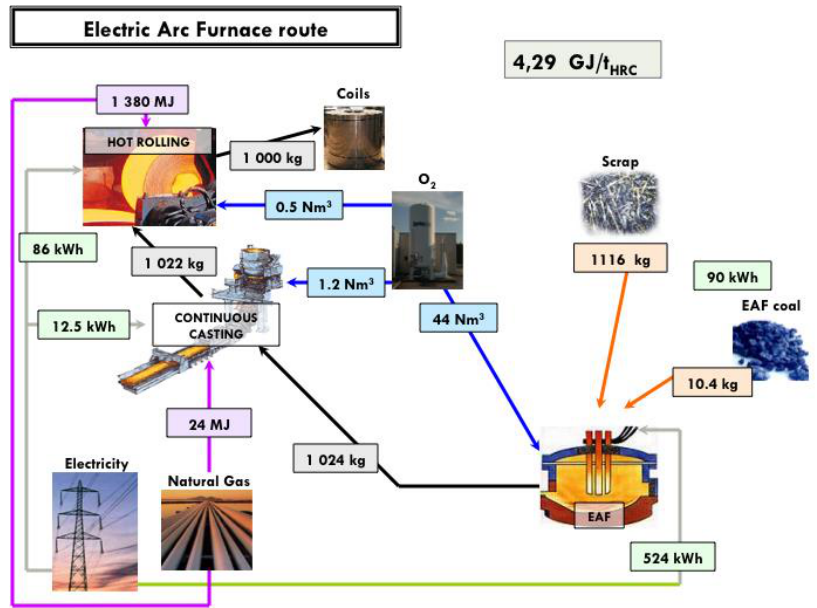
Figure 7. Mass and energy balance in an EAF steel mill fed with scrap.